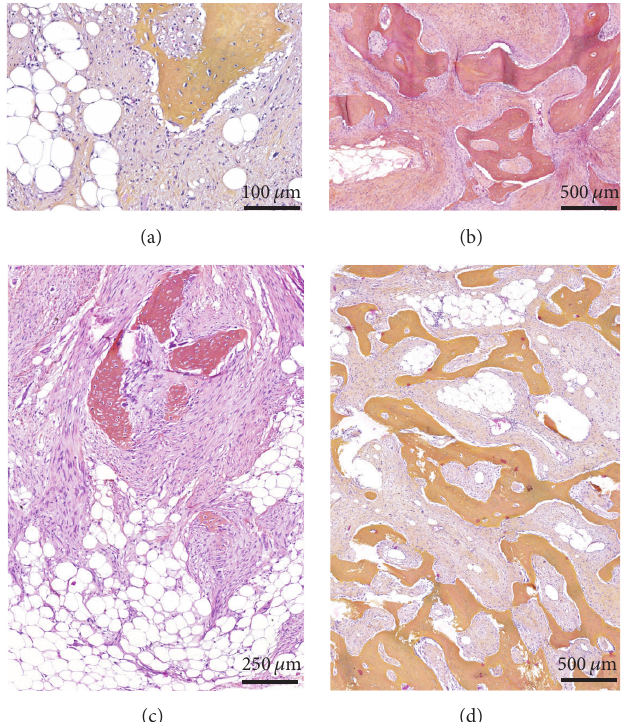
Figure 3: Histological features of the different occurrences of the tumor. (a) Well-differentiated liposarcoma component, first occurrence. Lipogenic clusters are entrapped within a stromal proliferation composed of fusiform cells. A cluster of bone formation is obvious. (b) Low- grade osteosarcoma component, first occurrence. The osteogenic areas are composed of long trabeculae of woven bone associated with the same proliferation of fusiform stromal cells in the intertrabecular spaces. These stromal cells are fusiform, elongated with moderate nuclear atypias. These morphological findings are very similar to low-grade osteosarcoma. (c) and (d) Histological aspects of the recurrences. The 2011 recurrence (c) and the 2014 recurrence (d) showed very similar histological findings compared to the first occurrence of the